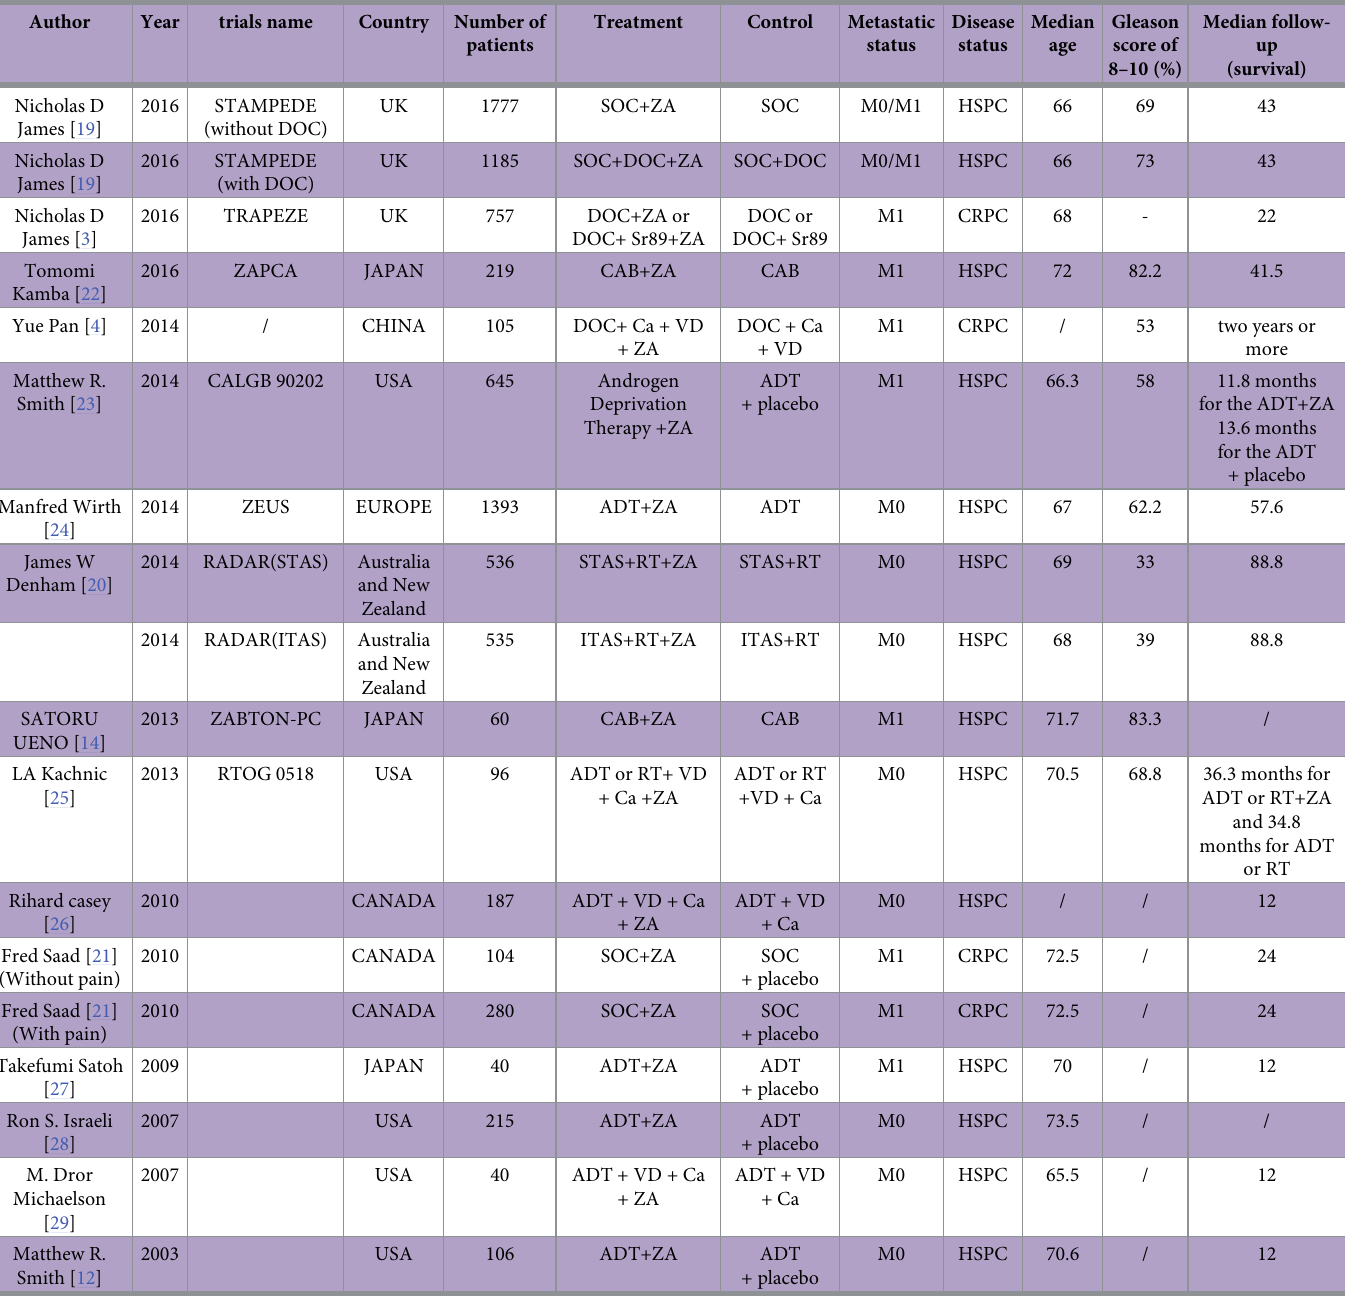
Table 1. Characteristics of